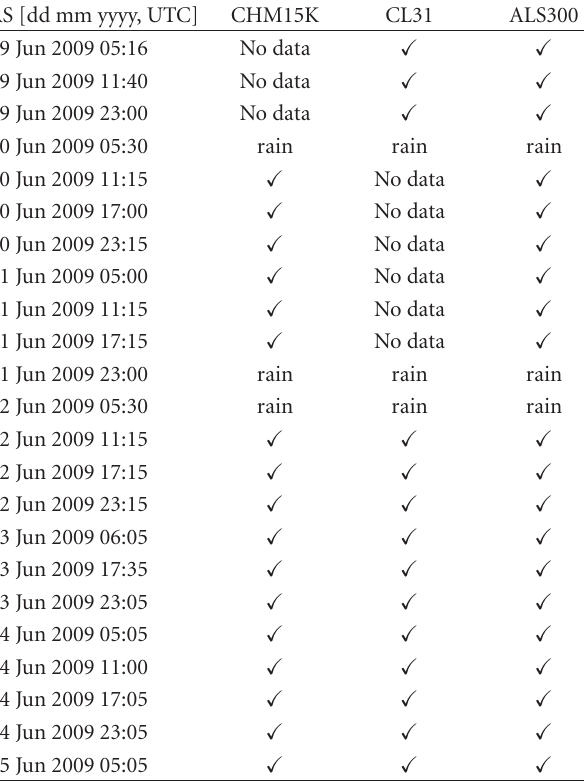
Table 2: List of backscatter data availability during the RS